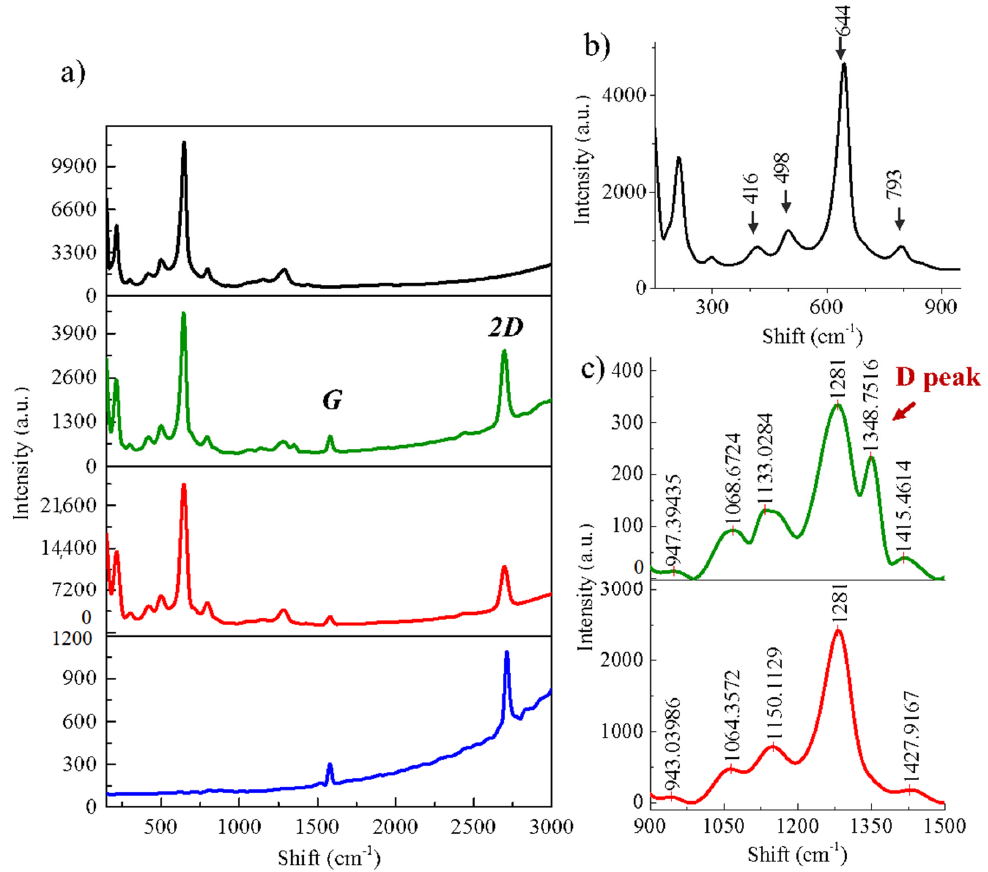
Figure 2. ( a ) Raman spectra corresponding to areas pointed in Figure 1.c using the same colors, ( b ) zoom-in between 0 and ( b ) zoom-in between 0 and 900 cm − 1 of the black spectrum showing Cu oxide peaks and ( c ) zoom-in 900 cm − 1 of the black spectrum showing Cu oxide peaks and ( c ) zoom-in between 900 cm − 1 and 1500 cm − 1 for the red and between 900 cm − 1 and 1500 cm − 1 for the red and green spectra of Figure green spectra of Figure 2a.